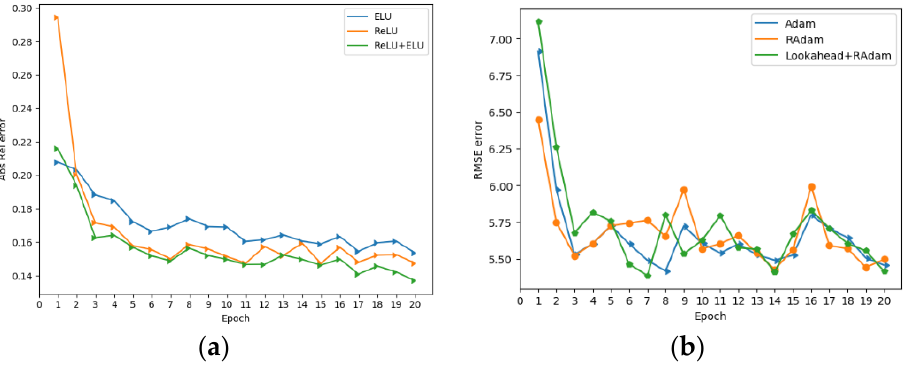
Figure 10. The effect of activation and optimization functions in our method. ( a ) A comparison of the Abs Rel test error and ( b ) a comparison of the RMSE test error.